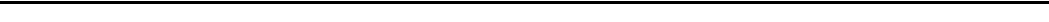
Fig. 5 STIL NTD interacts with CEP85 cc4 through a conserved interface. a High-resolution structure of Trichoplax adhaerens STIL NTD. Left, as ribbon presentation, rainbow coloured from N- to C-terminus. α -helices ( α ), β -sheets ( β ) and loops (L) are labelled consecutively. Right, equivalent view as molecular surface coloured by CONSURF evolutionary conservation score (right) from unconserved (cyan) to highly conserved (burgundy), revealing the presence of two conserved patches on the surface of Trichoplax adhaerens STIL NTD. Ringed in blue are residues L47 and R50 (L64 and R67 in human STIL) that are part of patch 1 and are located at the interaction interface in the CEP85-STIL complex as shown in c . b High-resolution structure of human CEP85 cc4 as ribbon presentation (rainbow coloured from N- to C-terminus) (left) and as molecular surface coloured by CONSURF evolutionary conservation score (right). The dashed box indicates the CEP85 cc4 region with visible electron density in the CEP85-STIL complex (shown in c ). Residues Q640 and E644 that are found at the interface of this complex are ringed in blue. c Complex of Trichoplax adhaerens STIL NTD and human CEP85 cc4 at a resolution of 4.6 Å, as a ribbon presentation. The correct register of the CEP85 cc4 was obtained by introducing methionines into CEP85 cc4 and calculating phased anomalous difference maps from corresponding selenomethionine-derivate data sets (Supplementary Fig. 4b). The human equivalents of the Trichoplax adhaerens STIL residues are indicated in brackets. d Mutation of conserved interface residues in STIL NTD and CEP85 cc4 compromises binding af fi nity. ITC measurements of chicken STIL NTD titrated into human CEP85 cc4 at 25 °C. Excess heat observed for the mutant proteins approach that obtained when titrating wild-type (WT) STIL NTD into buffer alone as a non-binding control. Conserved residues mutated in chicken STIL NTD are L60A and R63A, equivalent to L64 and R67A in human STIL (in brackets) and L47 and R50 in Trichoplax adhaerens (Fig.